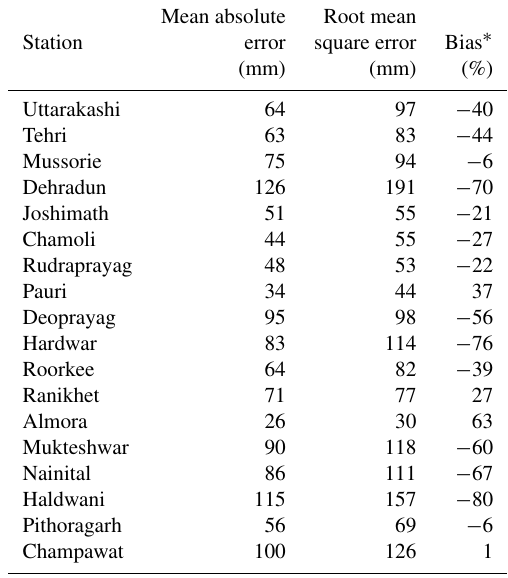
Table 1. Comparison of TMPA data with station